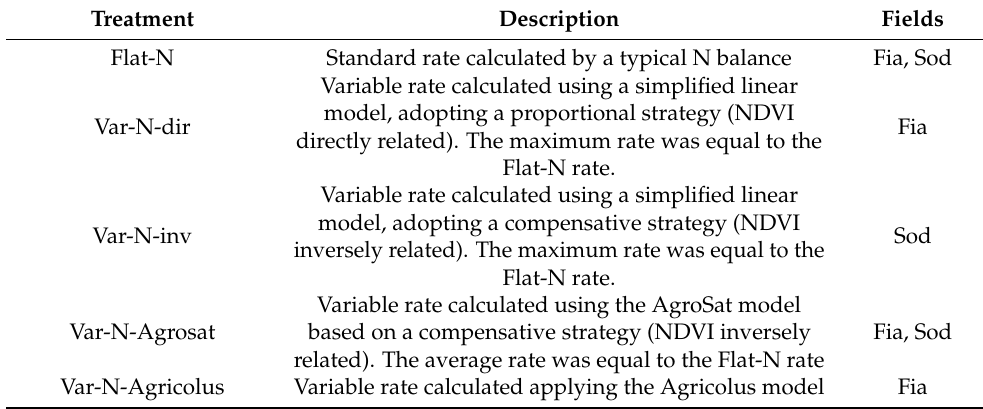
Table 4. Abbreviations and descriptions of the experimental treatments and the fields on which they were applied. Treatment Description Fields Flat-N Standard rate calculated by a typical N balance Fia, Sod Variable rate calculated using a simplified linear model, adopting a proportional strategy (NDVI Fia Var-N-dir directly related). The maximum rate was equal to the Flat-N rate. Variable rate calculated using a simplified linear model, adopting a compensative strategy (NDVI Var-N-inv Sod inversely related). The maximum rate was equal to the Flat-N rate. Variable rate calculated using the AgroSat model Var-N-Agrosat based on a compensative strategy (NDVI inversely Fia, Sod related). The average rate was equal to the Flat-N rate Var-N-Agricolus Variable rate calculated applying the Agricolus model Fia The NDVI data used for the Var-N-dir strategy were based on Sentinel-2 L2A images